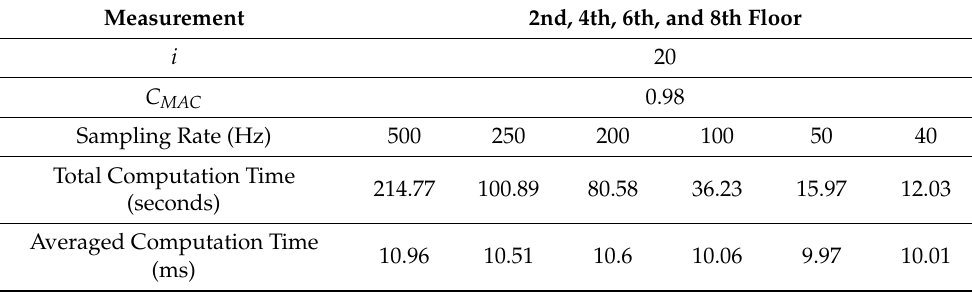
Table 2. The computation time over various sampling rates and a fixed i .